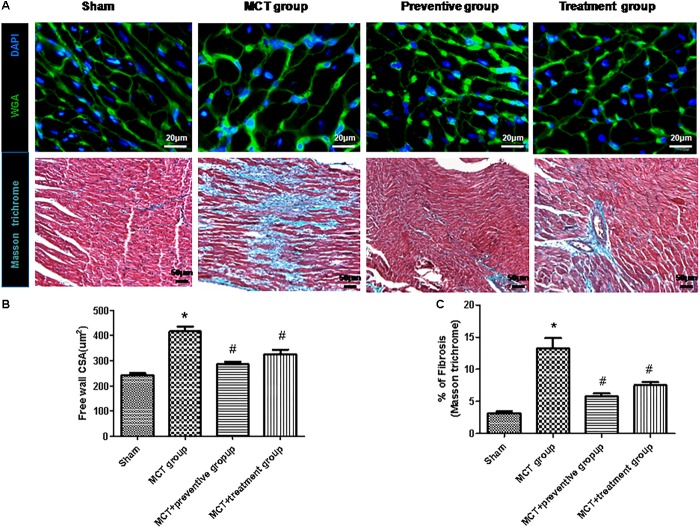
PNU-282987 on regulating cardiomyocyte size and collagen deposition in the right ventricle of MCT rats. (A) Representative images of the wheat germ agglutinin and Masson trichome staining of the right ventricle (RV), used to visualize and quantify the cardiomyocyte cross-sectional area and myocardial interstitial fibrosis in RVs, respectively, in the sham, MCT, MCT + PNU-282987 prevention and treatment groups. Myocytes are labeled with wheat germ agglutinin (green), nuclei are stained with DAPI (blue), original magnification: x400. Fibrosis presented as the blue stained area in the myocardium. Original magnification: x200. Images were observed in one millimeter from 10 separate images of different fields. (B) Quantification analysis of the cardiomyocte cross-sectional area (μm2). (C) Quantification analysis of interstitial fibrosis (%). The data are summarized as means ± SEM. ∗P < 0.05 versus the control group and #P < 0.05 versus the MCT group. Results shown are from one experiment (sham group, n = 15; MCT group, n = 8; MCT+protective group, n = 13; MCT+treatment group, n = 11).